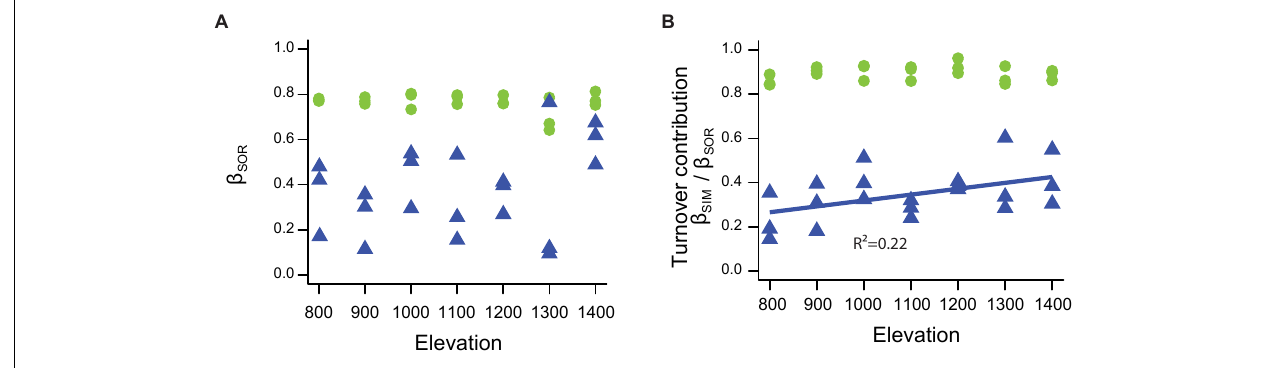
FIGURE 6 | Temporal taxonomic (green dots) and functional (blue triangles) β -diversity of ants along a tropical elevational gradient in Brazil. (A) Values of temporal β -diversity ( β SOR ) were not correlated with elevation and were always high, both for temporal taxonomic and functional diversity. (B) Temporal turnover contribution ( β SIM / β SOR ) to β -diversity was always high for taxonomic diversity whereas it increased with elevation for functional diversity. Data from ant communities sampled in 12 periods along an elevation gradient in Serra do Cipó, Minas Gerais State – Brazil. The figure represents four separated models (see section “Materials and